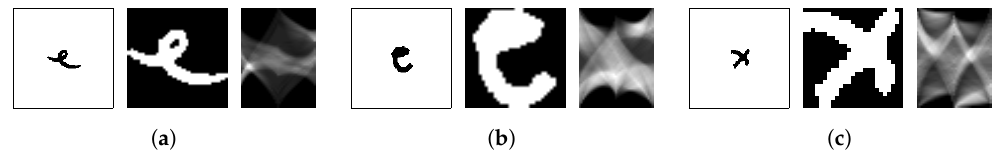
Figure 6. Samples of the NIST dataset before and after content highlighting, and MDIPFL transformation. Subfigures ( a , b ) represent character lowercase e . Subfigure ( c ) shows a sample of lowercase x